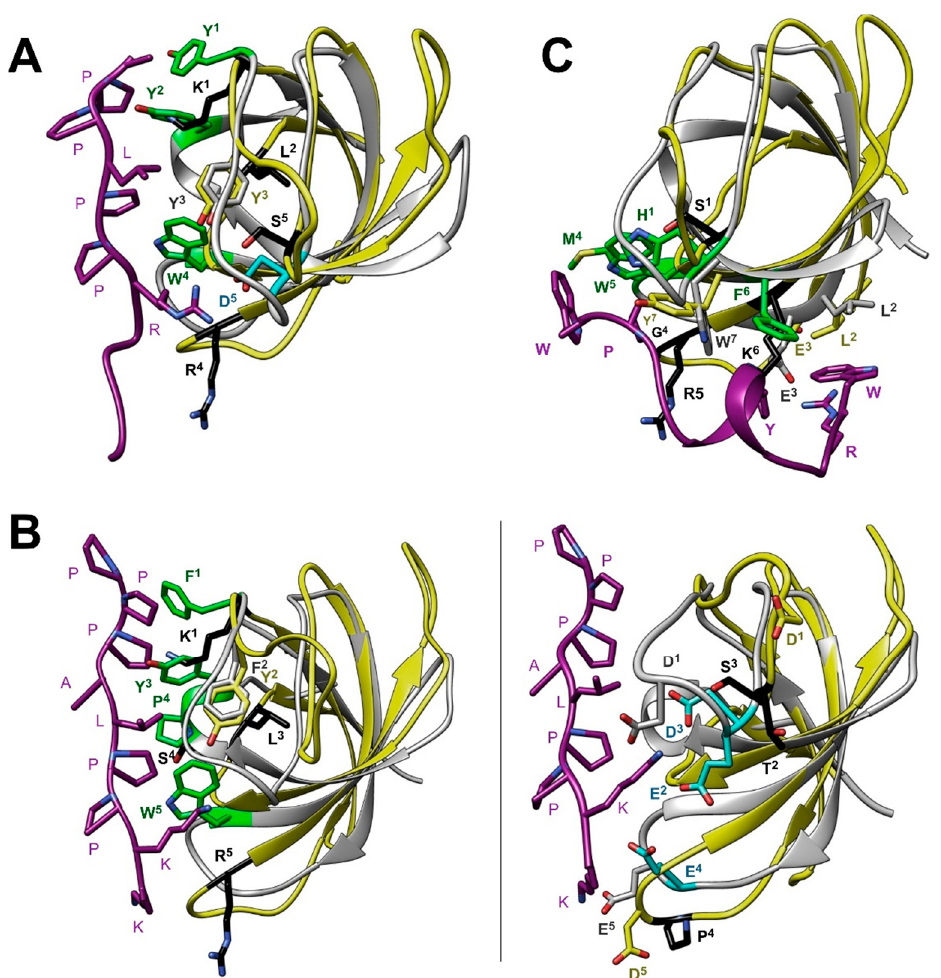
Figure 7. Superimposed ribbon diagrams of the SH3 domains of human Caskin1 (yellow, PDB: 7ATY) and ( A ) c-Src complexed with a proline-rich ligand (grey, PDB: 1QWE [47]), ( B ) c-Crk complexed with a proline-rich ligand (grey, PDB: 1CKA [48]), ( C ) intersectin-1 complexed with a synthetic proline-rich peptide (grey, PDB: 4IIM [49]). Side chains that have been found crucial for ligand binding in typical SH3 domains are indicated as sticks. For clarity, in the case of c-Crk, the PxxP ( left ) and specificity ( right ) site are shown separately. Aromatic (green) and acidic (cyan) residues, which have a key role in binding and are replaced by other residues (black) in Caskin1 are highlighted. Residue numbers are omitted for clarity. Superscripts are used to mark the same amino acid position in the superimposed structures to highlight the replacements in Caskin1. Oxigen, nitrogen, and sulfur atoms are in red, blue, and yellow, respectively. Ligands are shown in magenta.